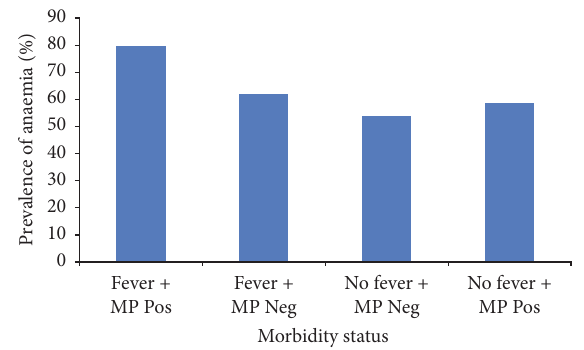
Figure 4: Prevalence of anaemia as influenced by morbidity status. MP Pos = malaria parasite positive. MP Neg = malaria parasite negative. Comparison of participants with fever + MP positive and those with fever and MP negative ( 𝜒 2 = 3.78 , 𝑃 = 0.052 ). Comparison of participants with no fever + MP negative versus those with no fever + MP positive ( 𝜒 2 = 0.20 , 𝑃 = 0.651